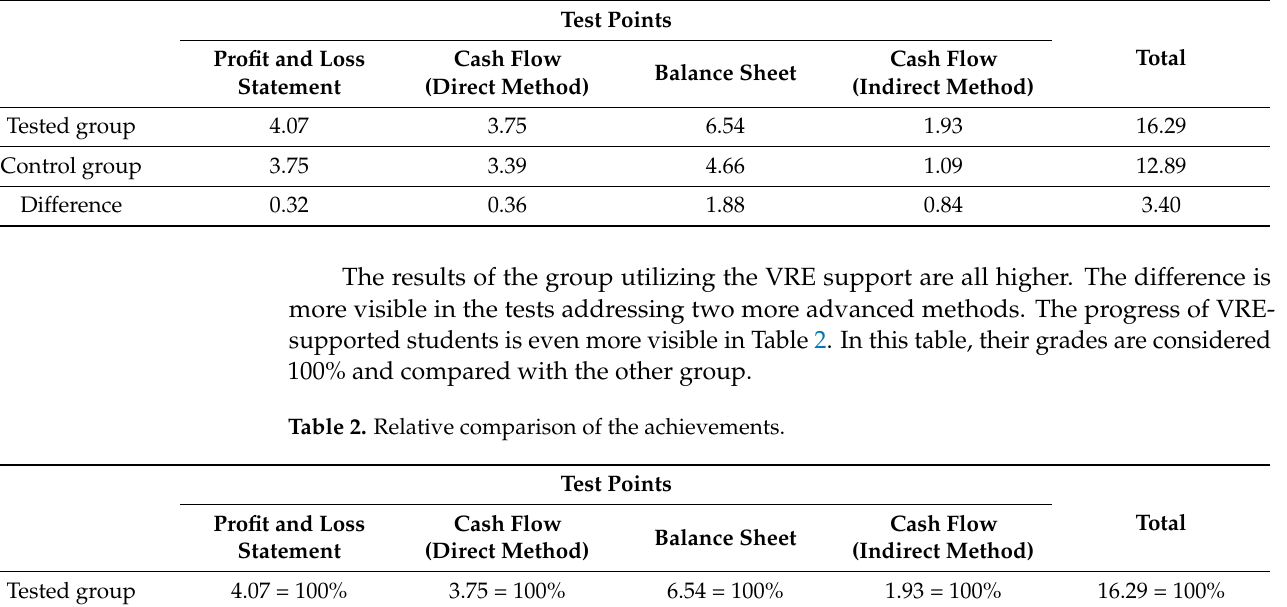
Table 1. Average achievements by the groups.